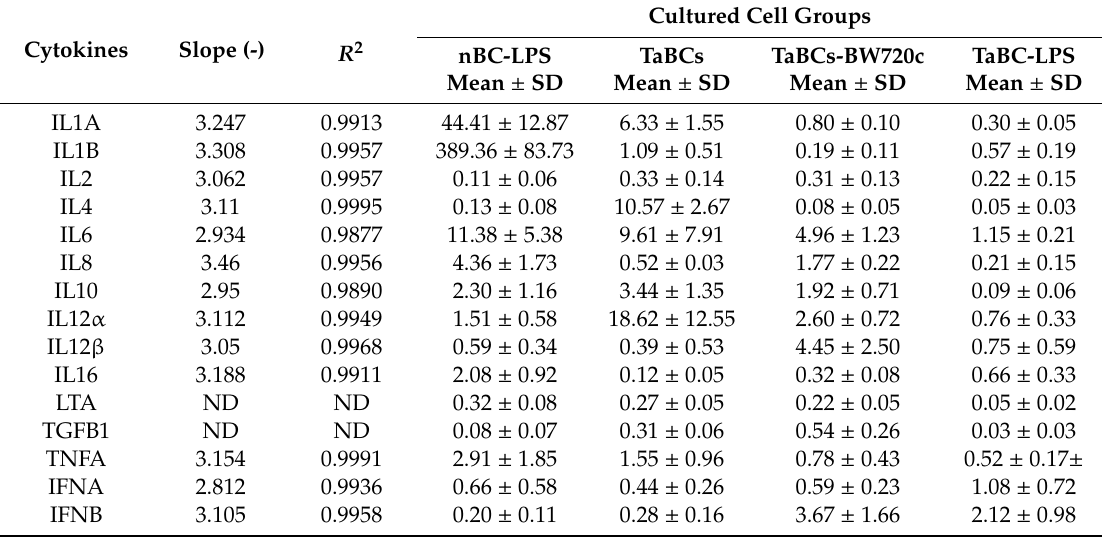
Here, ND (not done) depicts values that were already optimized in the literature and used in this study without optimization.